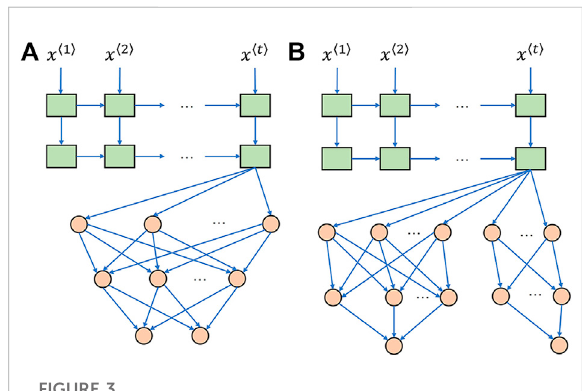
FIGURE 3 StackedLSTMnetworkfollowedbyfullyconnectedlayers. (A) Unbranched baseline model. (B) Branched baseline model. LSTM layers and fully connected layersare colored bygreenand orange,